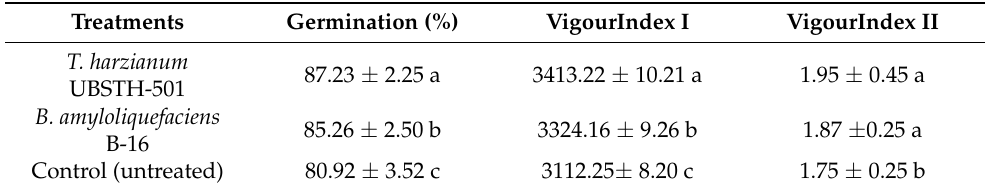
Table 2. Effect of bioagents on germination and vigour of wheat grown under salt stress conditions 30 days after